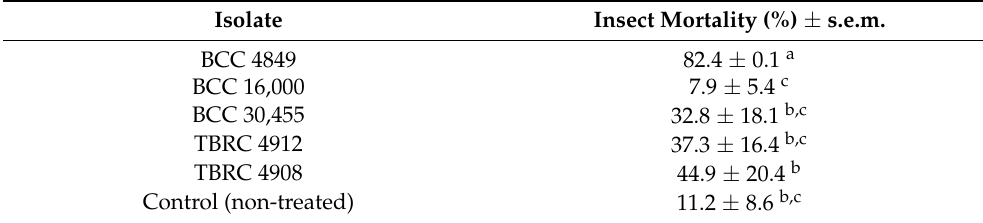
Table 1. Pathogenicity of Metarhizium isolates against the spider mite ( Tetranychus truncatus ) at the 5th day post inoculation (dpi).